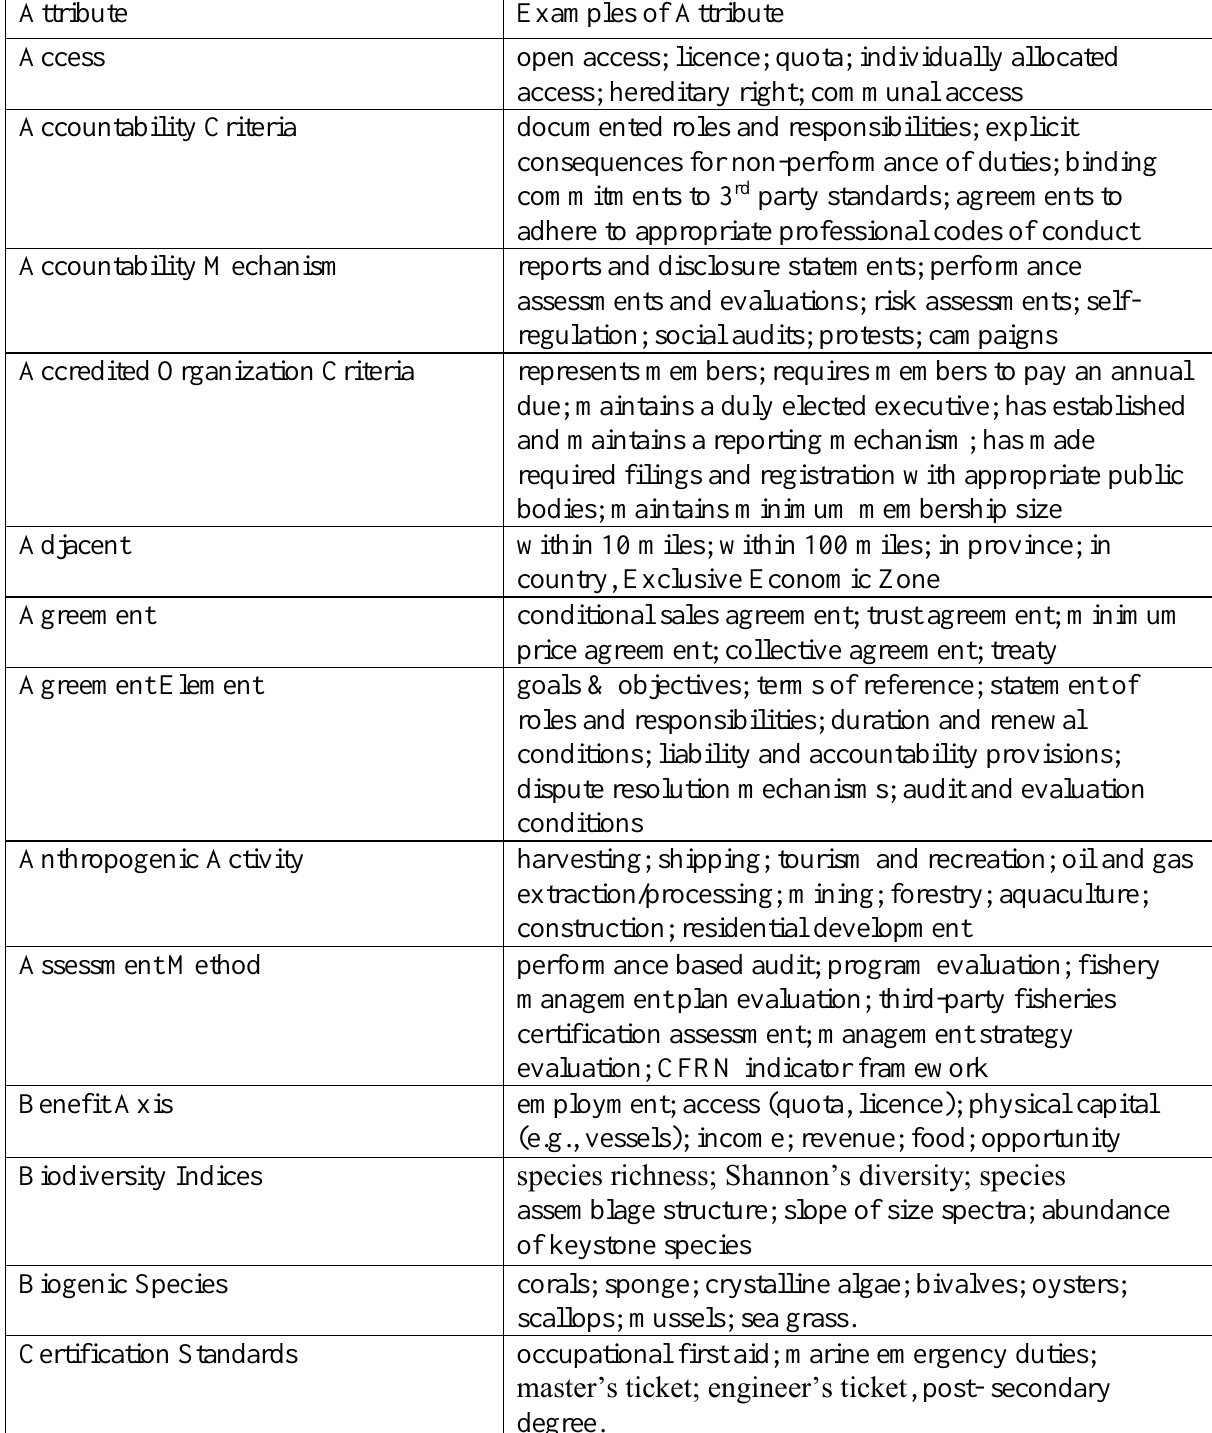
Table A1.10: ATTRIBUTES